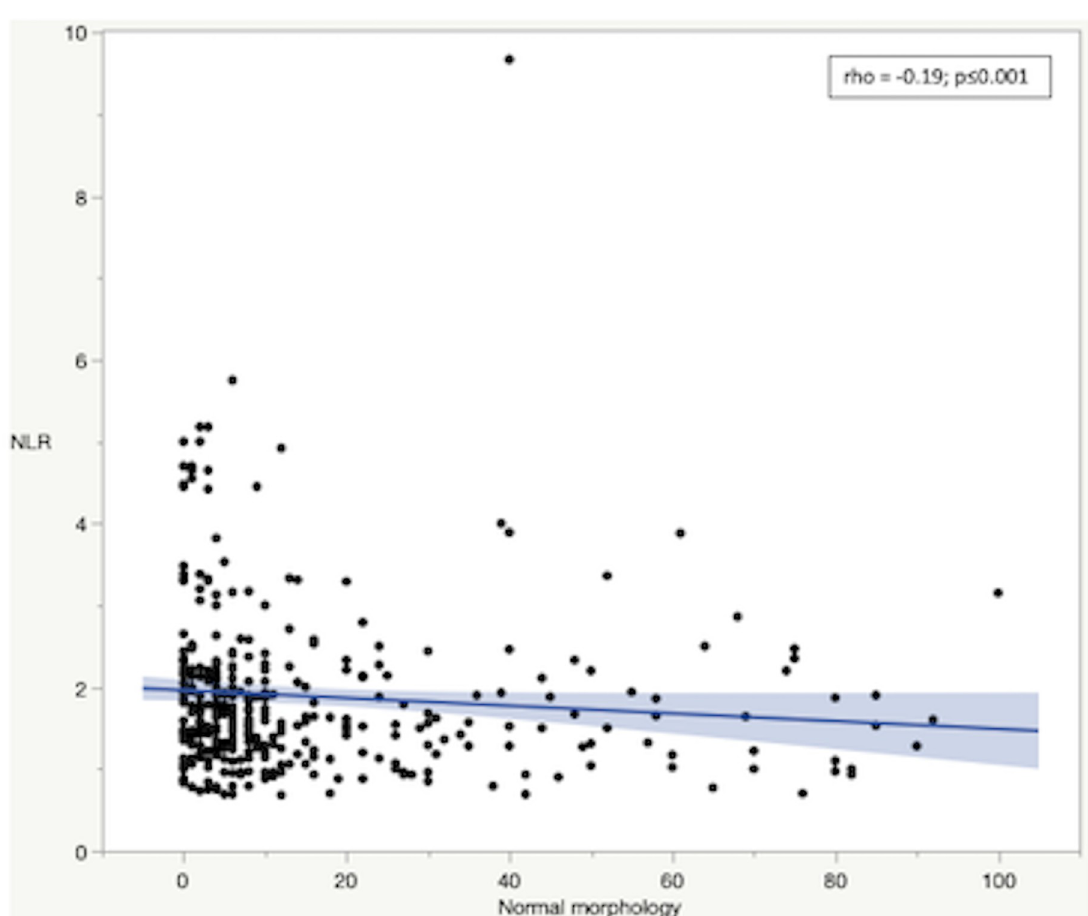
Fig 3. Correlation between Neutrophil-to-Lymphocyte Ratio (NLR) and normal sperm morphology in infertile men. Rho and p- value according to Spearman’s correlation.